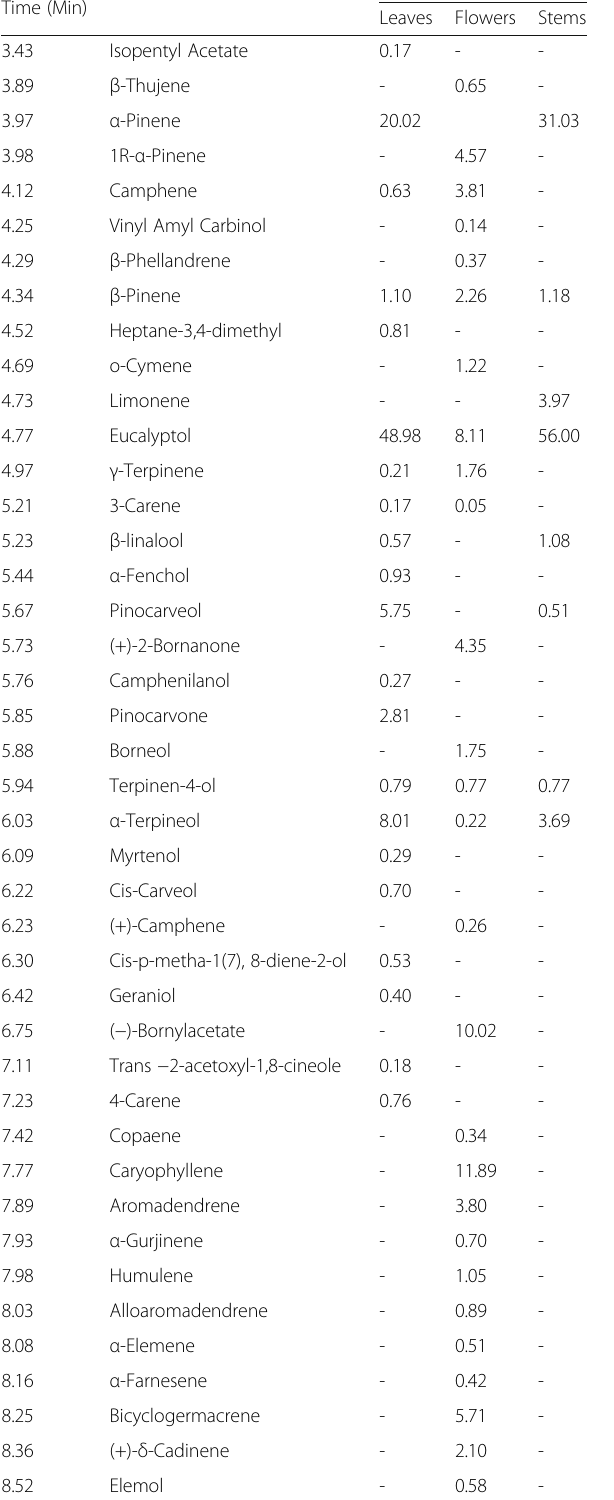
Table 1 Fractional compositions of constituents of the leaves flowers and stems oil of Callistemon citrinus Retention Constituents Time (Min)